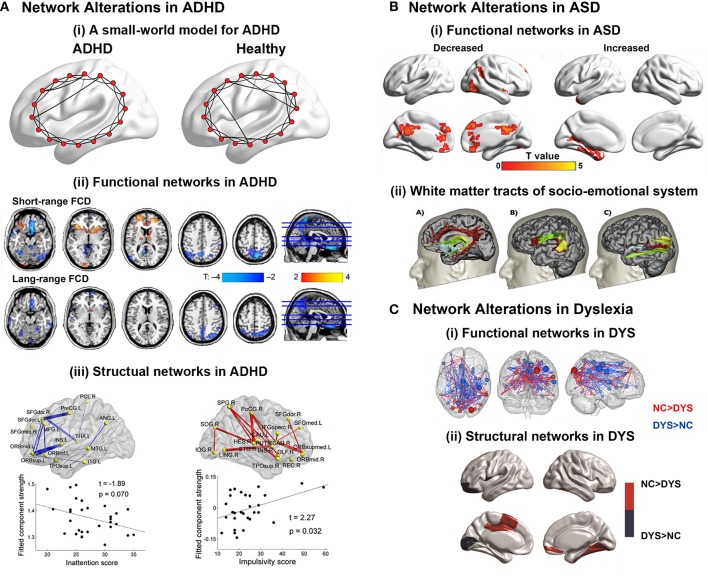
(A) Brain network alterations in ADHD. (i) Small-world models for ADHD and healthy brain networks. The ADHD networks showed a regular tendency compared with healthy controls. Adapted from Cao et al. (2014a). (ii) Decreased or increased functional connectivity density (FCD) in ADHD patients compared with healthy controls. Adapted from Tomasi and Volkow (2012). (iii) Decreased or increased white matter connections in ADHD participants compared with healthy controls and their relationships with the clinical characteristics of the patients. Blue curve: the significantly decreased network-based statistic (NBS) component; red curve: the significantly increased NBS component. Adapted from Cao et al. (2013). (B) Brain regions displaying disrupted functional connectivity in autism. (i) Voxels displaying altered functional connectivity in autism. Voxels that displayed weaker functional connectivity in the autistic population than in the controls are shown in blue, and the voxels that displayed stronger functional connectivity in the autistic population are shown in red. The color bar represents the degree of connectivity according to the number of significantly affected edges relating to a given voxel. Adapted from Eilam-Stock et al. (2014). (ii) White matter tracts of the socio-emotional processing system. Left: white matter tracts of the limbic system; middle: white matter tracts linking the mirror neuron system; right: white matter tracts of the face processing system. Adapted from Ameis and Catani (2015). (C) Brain network alterations in dyslexia. (i) Whole-brain functional connectivity differences between groups. Three-dimensional representation of healthy controls readers (NC) > dyslexic readers (DYS) and DYS > NC edge components (p < 0.01 after NBS correction). Adapted from Finn et al. (2014). (ii) Between-group differences in regional nodal characteristics in cortical thickness networks. Group differences of and nodal degree in cortical thickness networks. Blue represents the brain areas with significantly lower nodal properties in DYS than in NC, whereas red represents the brain areas with significantly higher nodal properties in NC than in DYS. Adapted from Qi et al. (2016).